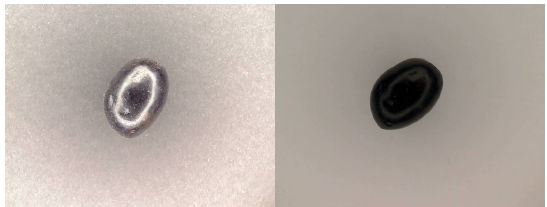
Figure 3. Difference contrasts with different background